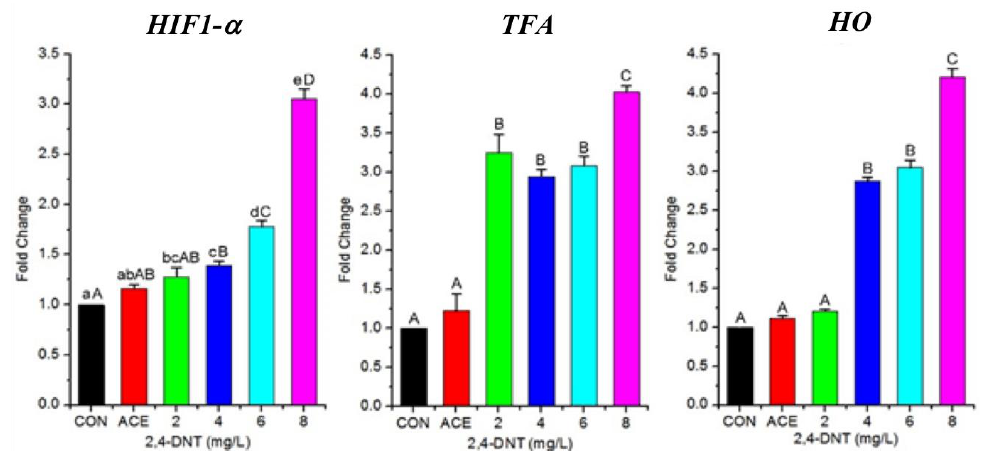
Figure 7. Relative mRNA expression levels of genes involved in respiration in zebrafish larvae exposed to 2,4-DNT at 5 dpf. Abbreviations: CON: control group; ACE: acetone group; HIF1- α : hypoxia inducible factor 1, alpha subunit; TFA: transferrin-a; HO: heme oxygenase; values are means ± SEM ( n = 3). Bars that do not share a common lower-case letter are significantly di ff erent between the treatments ( p < 0.05). Bars that do not share a common capital letter are significantly di ff erent between the treatments ( p < 0.01).